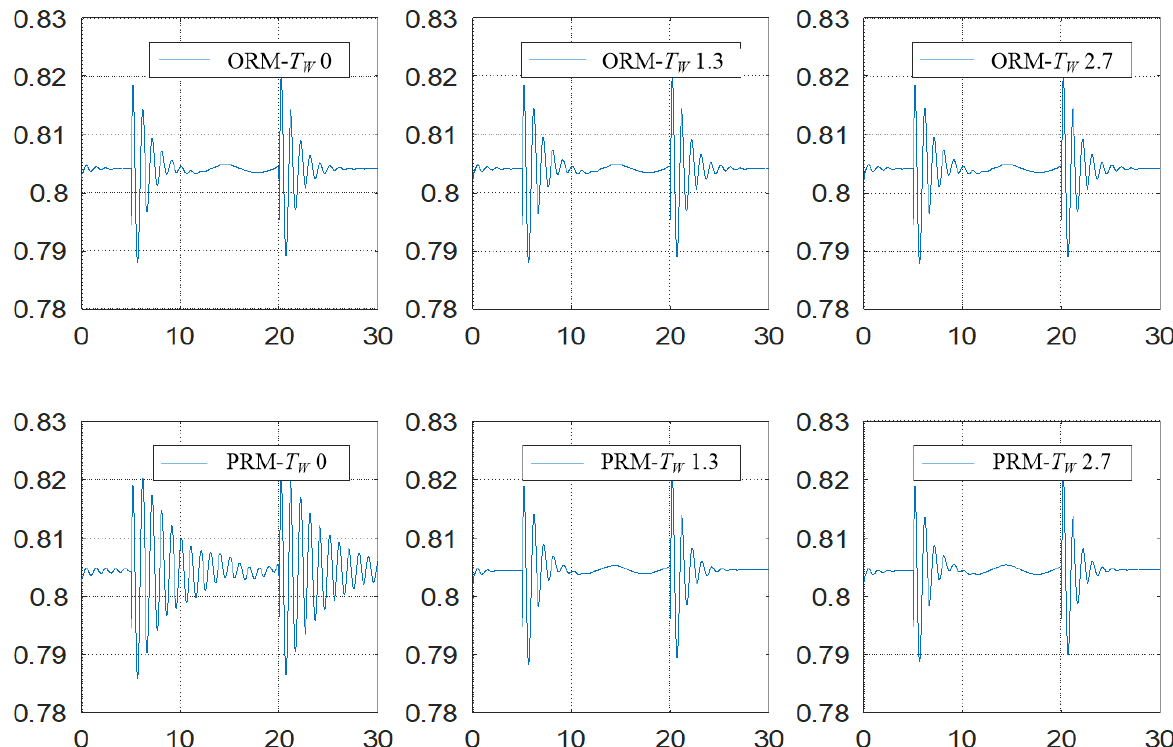
Figure 14. Response of output power P under voltage fluctuation.